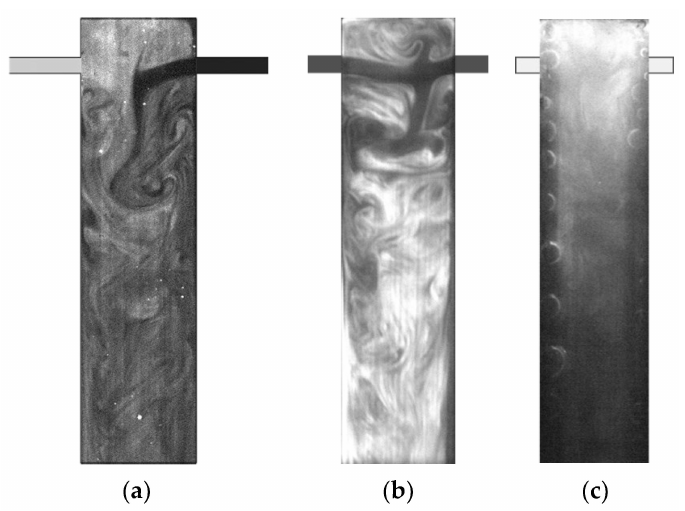
Figure 12. PLIF images obtained from ( a ) non-reactive rhodamine tracer; ( b ) AB-RPLIF method; ( c ) Oxi-RPLIF